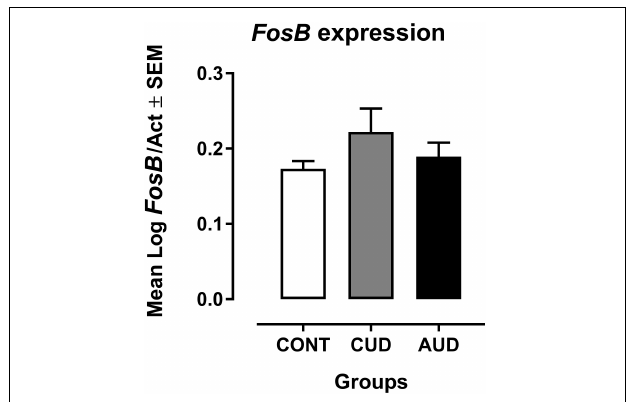
FIGURE 1 | Mean Log FosB /Act values from both CUD ( n = 10) and AUD ( n = 12) patients compared from the mean of the control group (CONT, n = 12). Larger Ct values reflect later threshold cycle, that is, the quantitative cycle in which the target was captured is delayed, meaning that the target is less